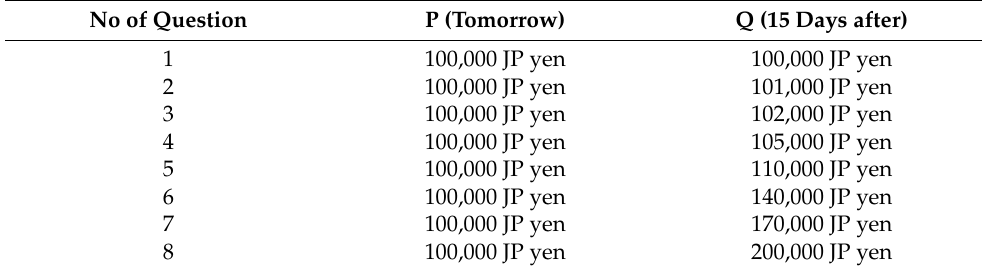
Table 2. Questions to measure the time